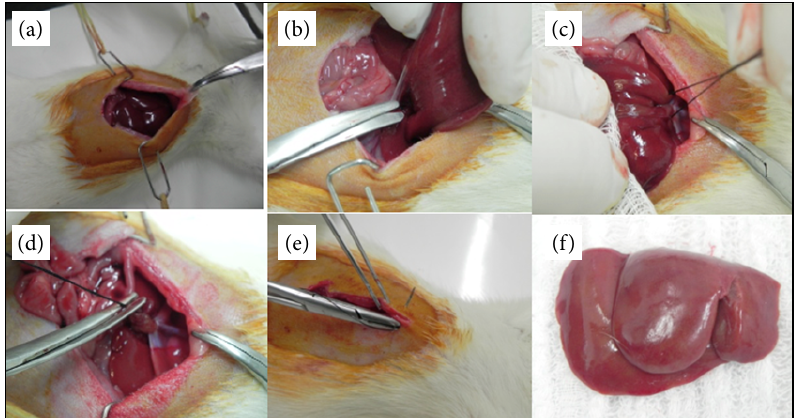
Figure 1 - Technique of 70% hepatectomy. (a) Median laparotomy and installation of metallic retractors; (b) Liver dissection and ligamentous section; (c)